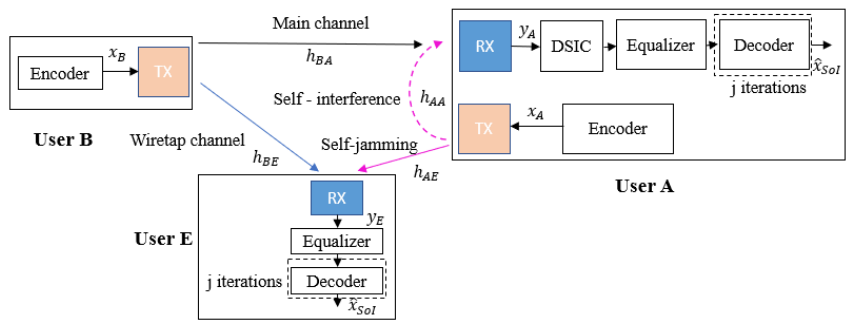
Figure 4. Blind scheme without feedback at user A in case of a passive eavesdropper.